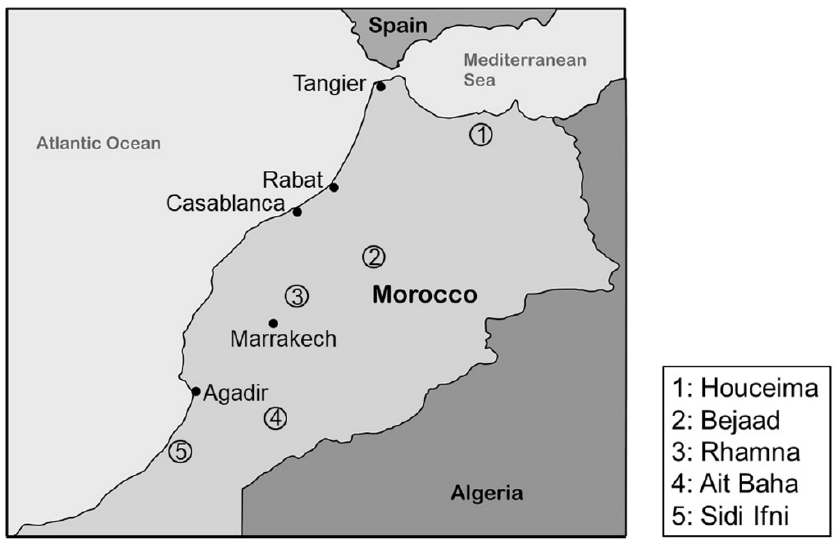
Figure 1. Location of the evaluated cactus seed sites of production in